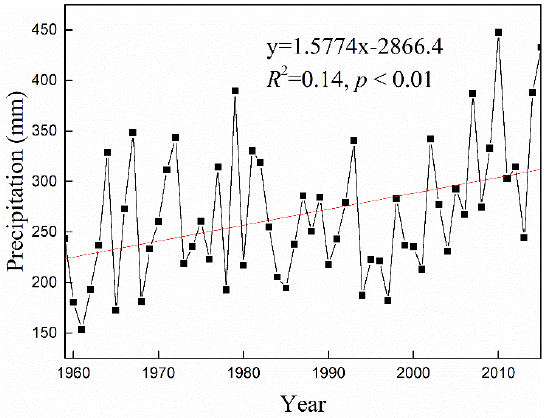
Figure 5. Reconstructed annual precipitation at AWS1 during 1959–2015.